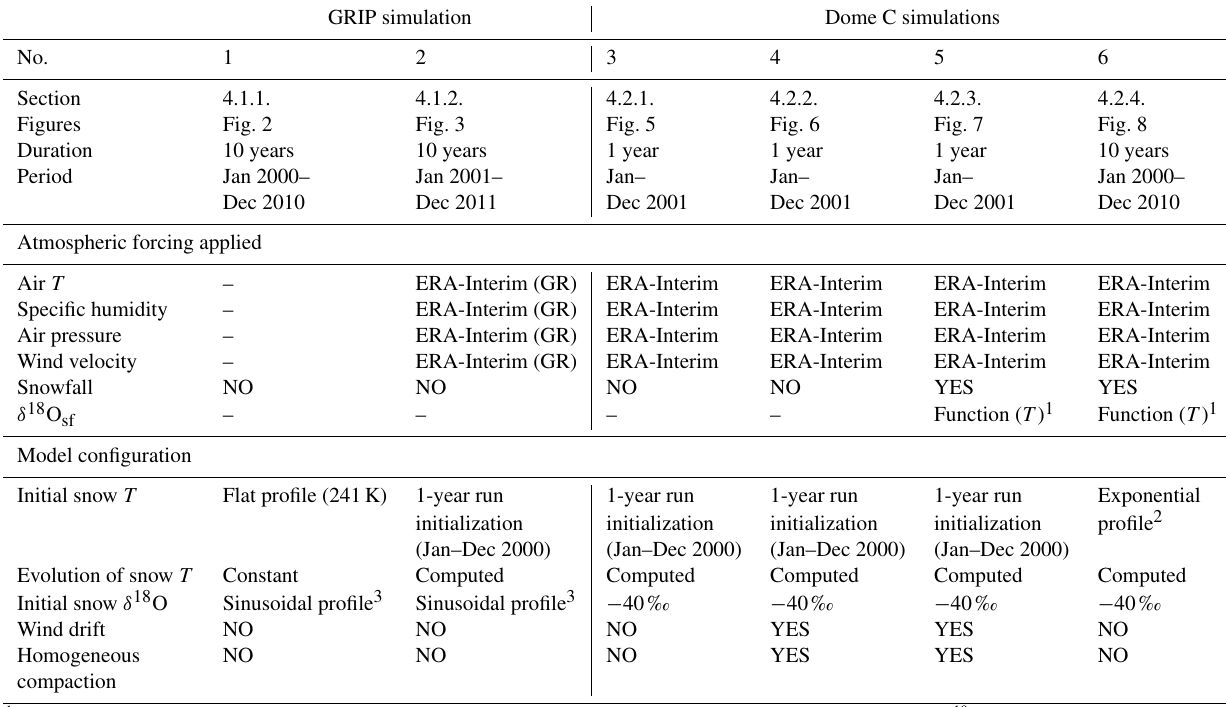
Table 4. List of simulations described in the article with the corresponding paragraph number. The external atmospheric forcing used for Dome C is ERA-Interim reanalysis (2000–2013). However, the precipitation amounts from the ERA-Interim reanalysis are increased by 1.5 times to account for the dry bias in the reanalysis (as in Libois et al., 2014). For the second simulation at GRIP, Greenland meteorological conditions are derived from the atmospheric forcing of Dome C, but the temperature is modified ( T GRIP = T DC + 15) as is the longwave down (LW GRIP = 0 . 85LW DC +